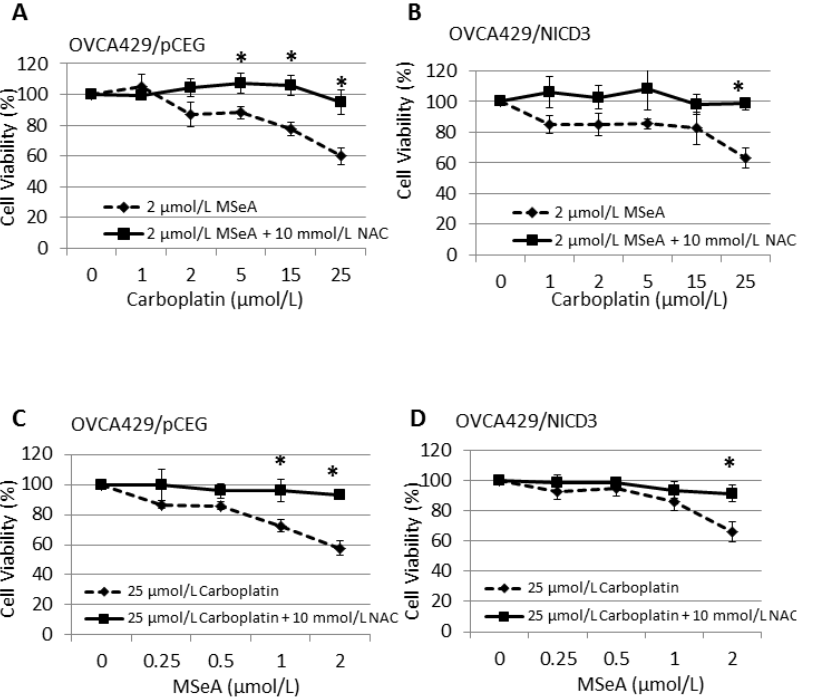
Figure 2. The effect of NAC on the sensitivity of OVCA429/pCEG and OVCA429/NICD3 cells to MSeA and carboplatin co-treatment. OVCA429/pCEG ( A , C ) and OVCA429/NICD3 ( B , D ) cells were treated with MSeA and a gradient concentration of carboplatin ( A , B ) or carboplatin and a gradient concentration of MSeA ( C , D ) in the presence or absence of NAC. Cell viability was determined by SRB assay. Viability of the cells without carboplatin ( A , B ) or MSeA ( C , D ) treatment was set as 100%. Values are mean 6 S.E.M. (n = 3). *, p , 0.05, compared to MSeA or carboplatin only treatment. doi:10.1371/journal.pone.0101664.g002 PLOS ONE |